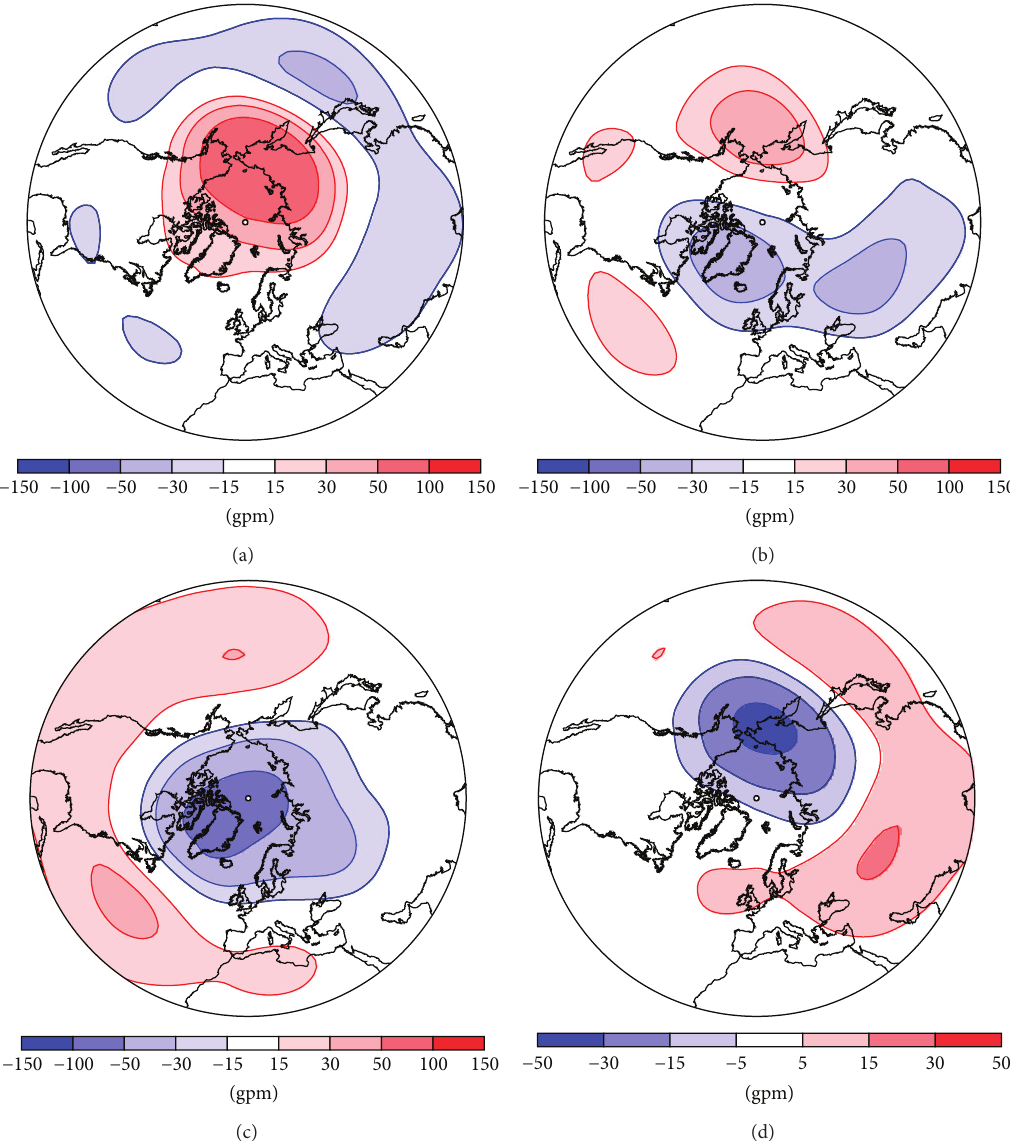
Figure 11: Composite geopotential height (gpm) anomaly patterns of the modeled regimes of the control run (areas A–D in Figure 10 left) at the 833 hPa